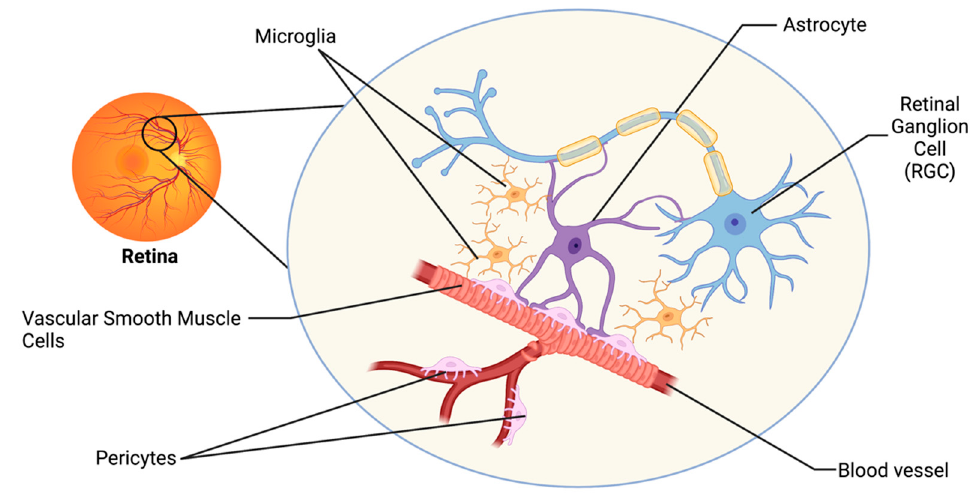
Figure 1. The retinal neurovascular unit. The retinal NVU consists of three main cell types: neurons (retinal ganglion cells; RGCs), glial cells (including astrocytes and microglia), and vascular cells (including endothelial cells, vascular smooth muscle cells, and pericytes).